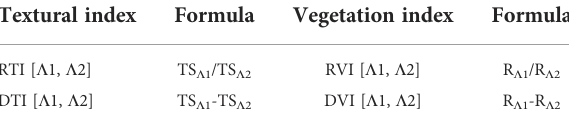
TABLE 3 Formulas of textural and spectral index calculation.